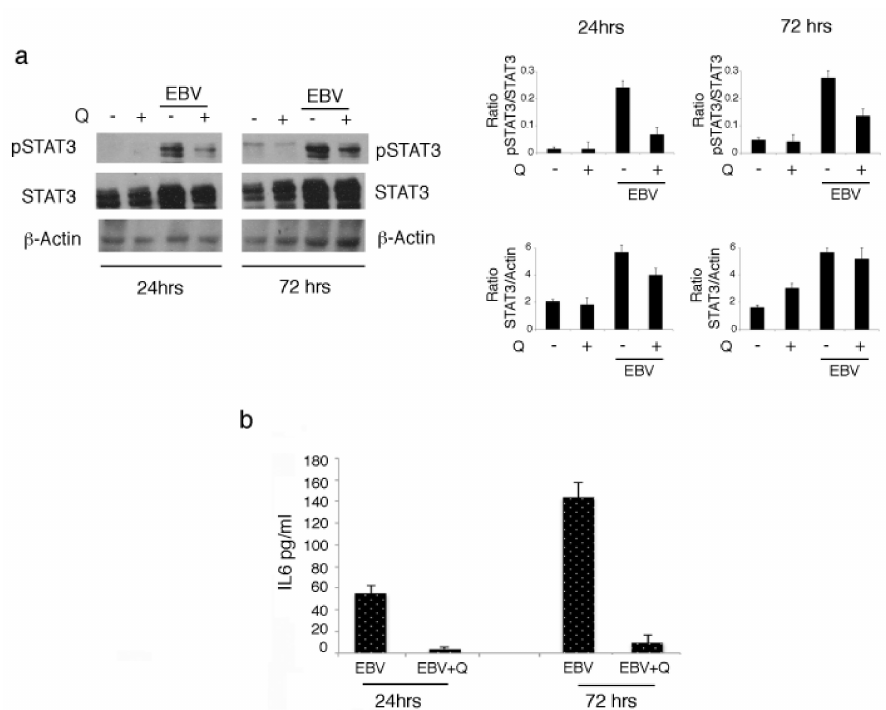
Figure 2. Quercetin inhibits the crosstalk between signal transducer and activator of transcription 3 (STAT3) and interleukin-6 (IL-6) in EBV-infected cells. ( a ) Western blot analysis of STAT3 705 Tyr phosphorylation evaluated following EBV infection of B cells in the presence or absence of quercetin at 24 and 72 h post-infection. Densitometric analysis was performed using Image J software, and the ratio of p-STAT3 vs. STAT3 or of STAT3 versus β -actin, was calculated. Histograms represent the mean ± SD of three independent experiments. ( b ) IL-6 release by EBV-infected cells in the presence or in the absence of quercetin at 24 and 72 h. Histograms represent the mean ± standard deviation (SD) of IL-6 release (pg / mL) from three independent